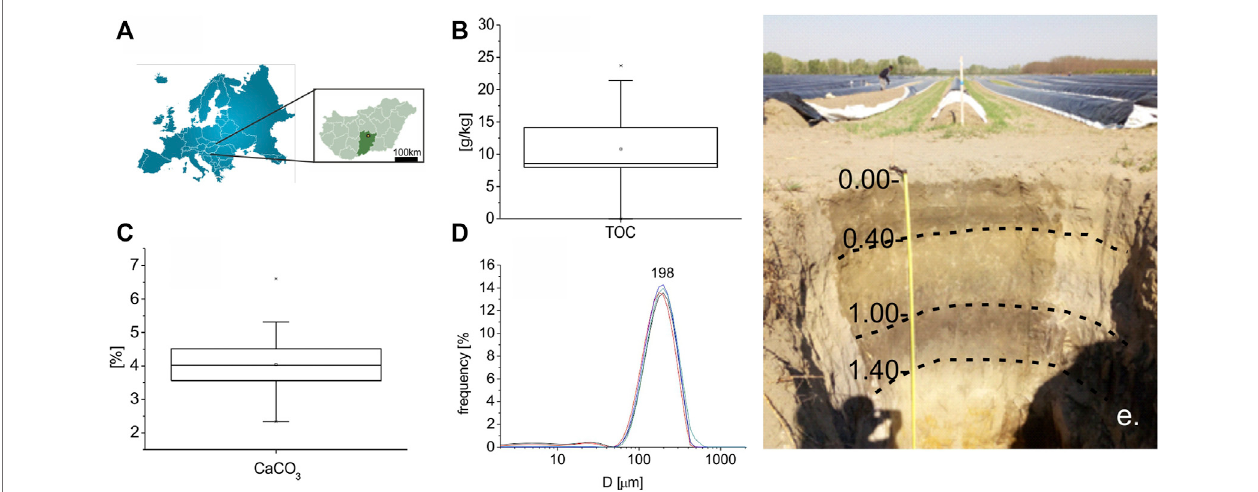
FIGURE1| Asparagus fi eldwithsoilpro fi leandtopsoilproperties. (A) ,location; (B) ,totalorganiccarbon; (C) ,carbonatecontent; (D) ,particlesizedistributionofthe top layer; (E) , soil pro fi le (0 – 0.40 m: cultivated, 0.4 – 1.00 arenic, 1.00 – 1.40 buried organic, > 1.40 plinthic).